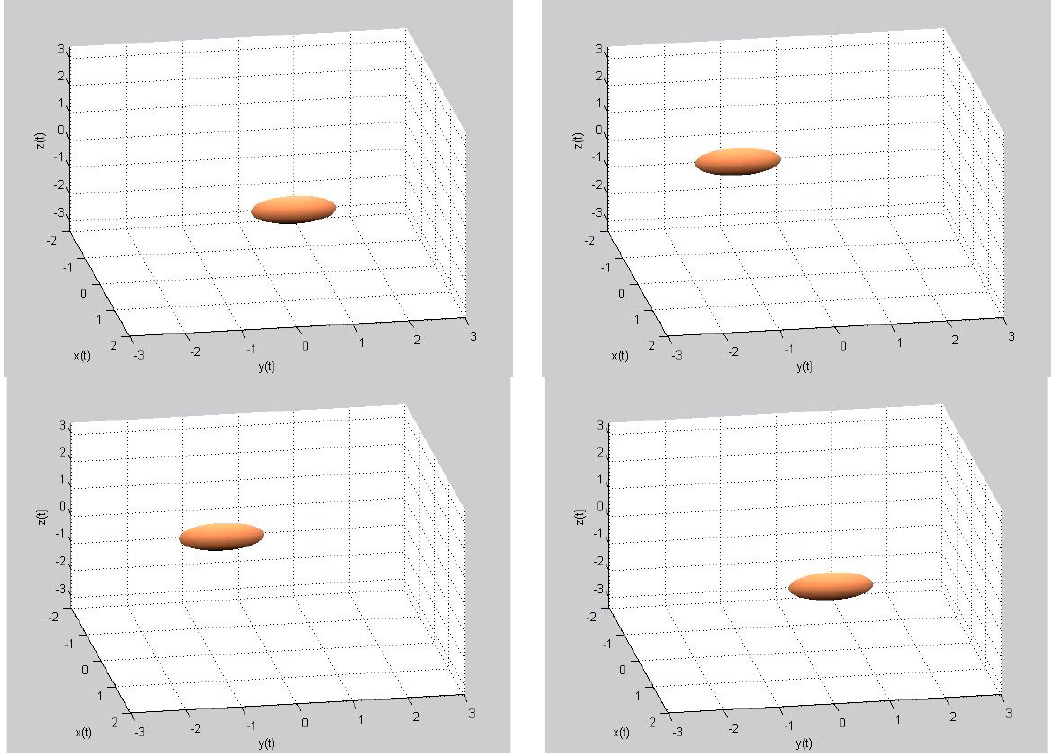
Figure 7. Frames from the created Matlab movie for the larynx movement.